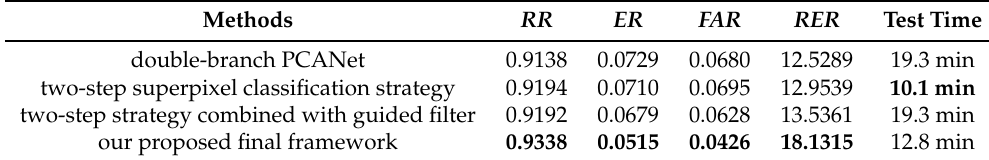
Table 3. Statistical results of different cloud detection frameworks.